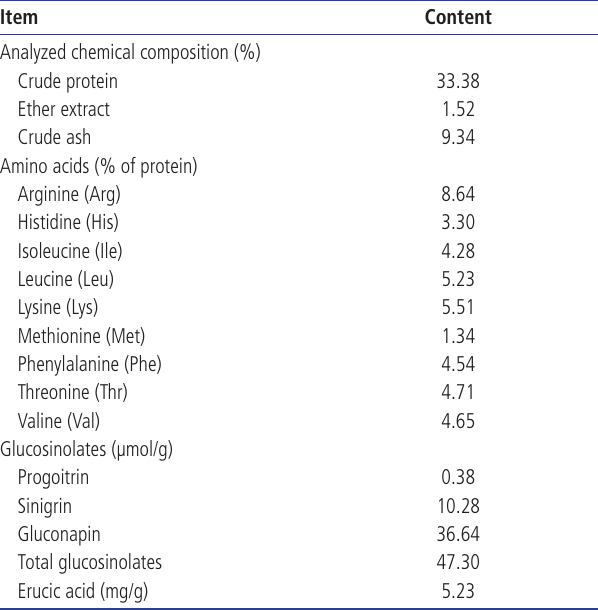
Table 1. Chemical composition and anti-nutritional factors content of